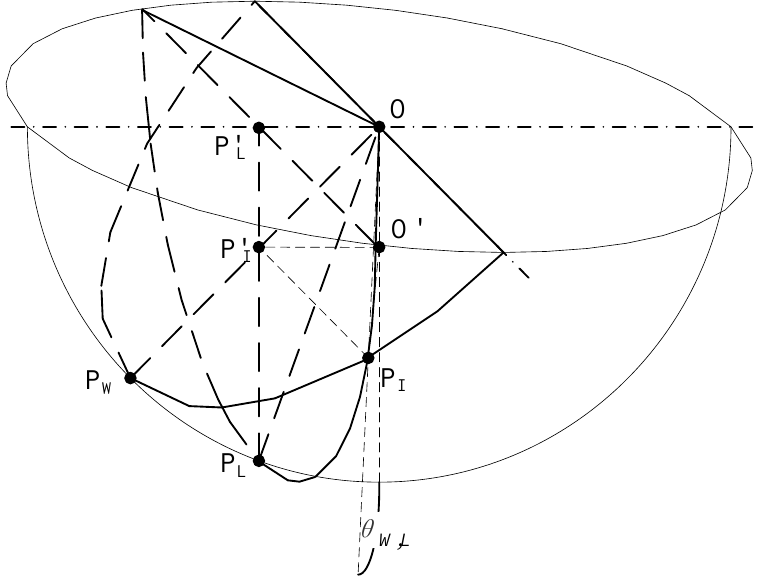
Figure A4. Ω L geometric sketch 2.